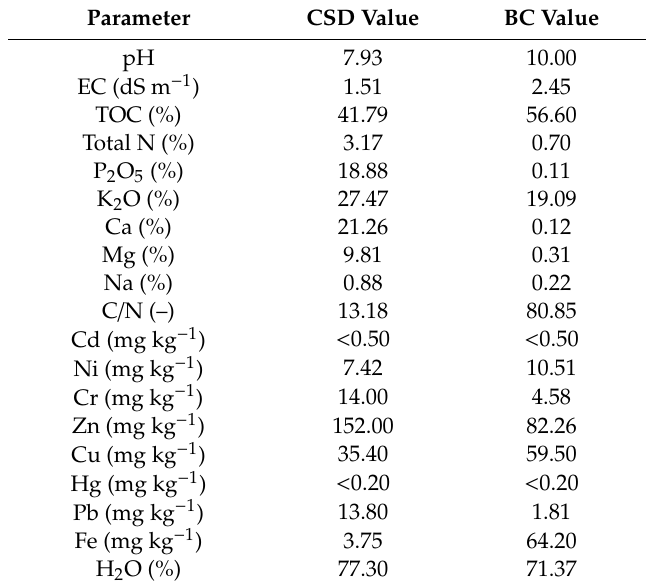
Table 1. Main chemical characteristics of composted solid digestate (CSD) and biochar (BC).